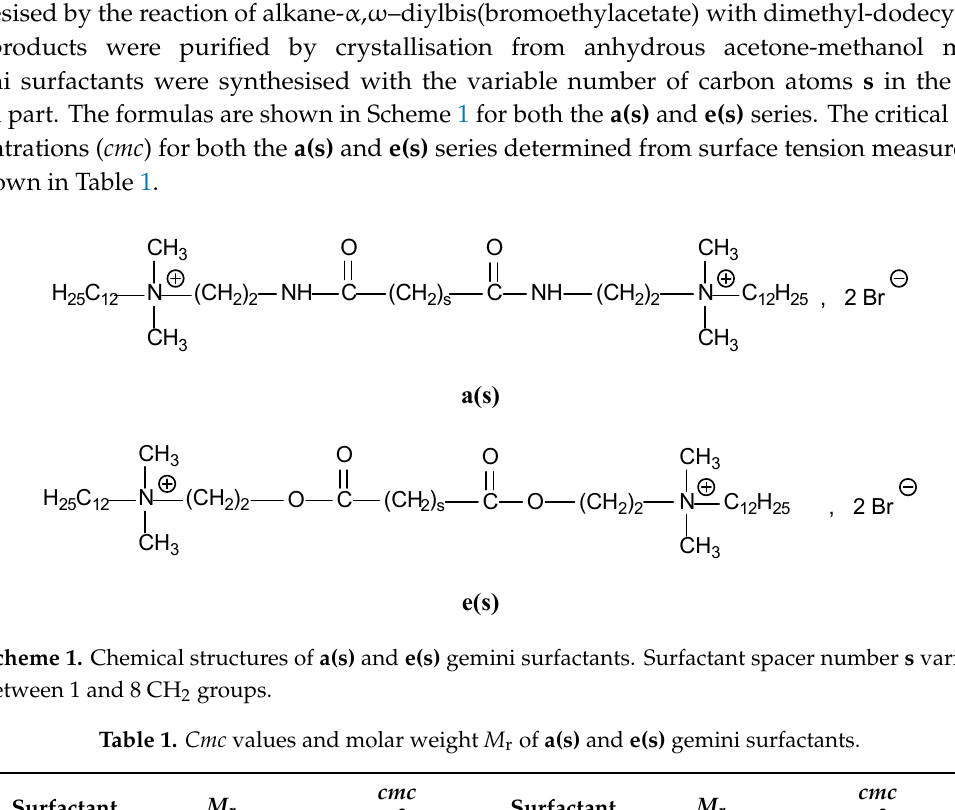
Table 1. Cmc values and molar weight M r of a(s) and e(s) gemini surfactants.